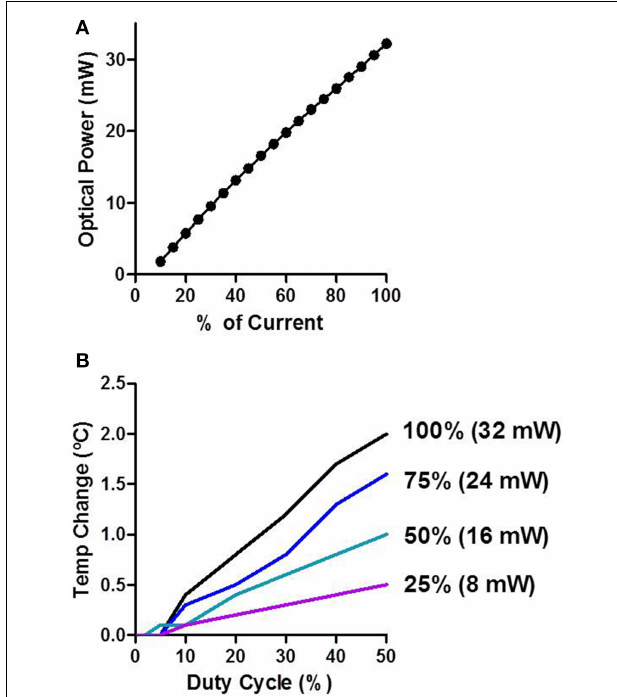
FIGURE 3 | Characterization of LED stimulation. (A) Optical power increases linearly as a function of the input current. (B) Temperature change was measured in vivo . The temperature increases as a function of the duty cycle and the percent of input current.